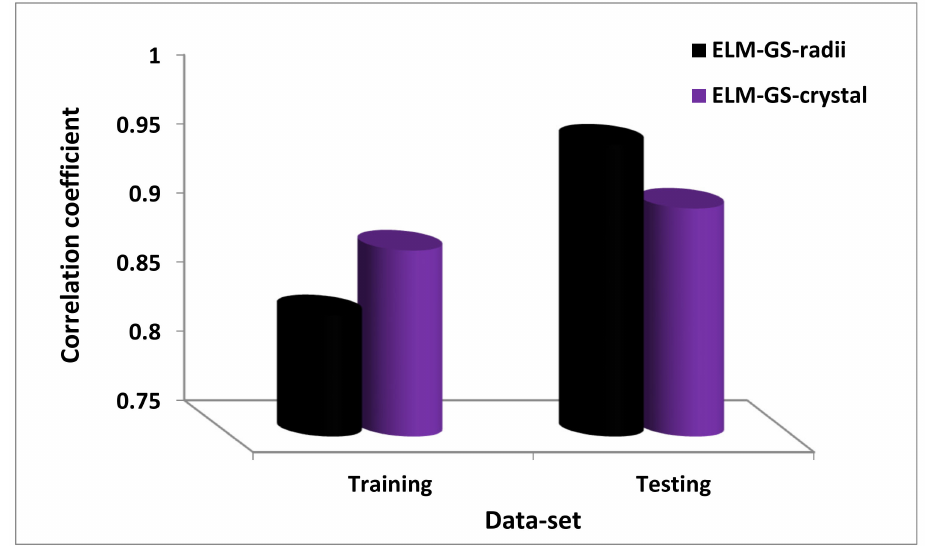
Figure 6. Comparison between the ELM-GS-radii and ELM-GS-crystal models on the basis of the correlation coe ffi